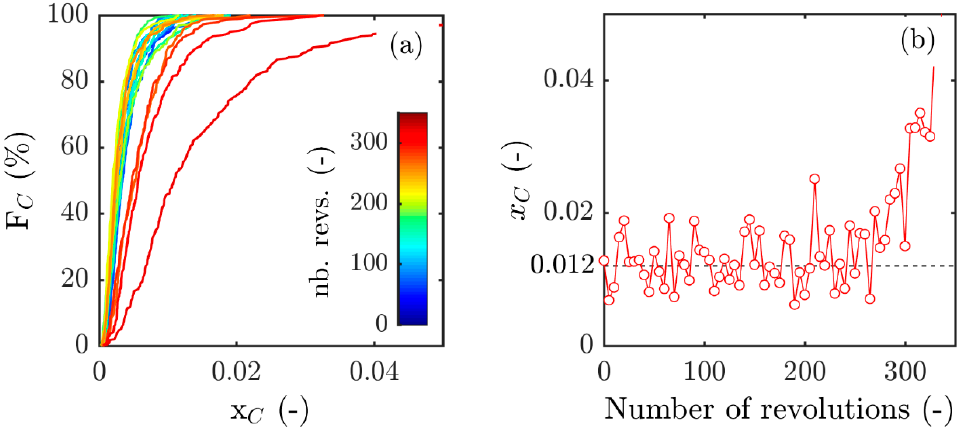
Figure 7. ( a ) Correlation cumulative distribution functions (computed over 5 revolutions and displayed every 20) as a function of the correlation value; ( b ) iso-level of distribution. Sensor location: (x, θ ) = ( − 0.06.C x , 90°); moderate throttling speed.